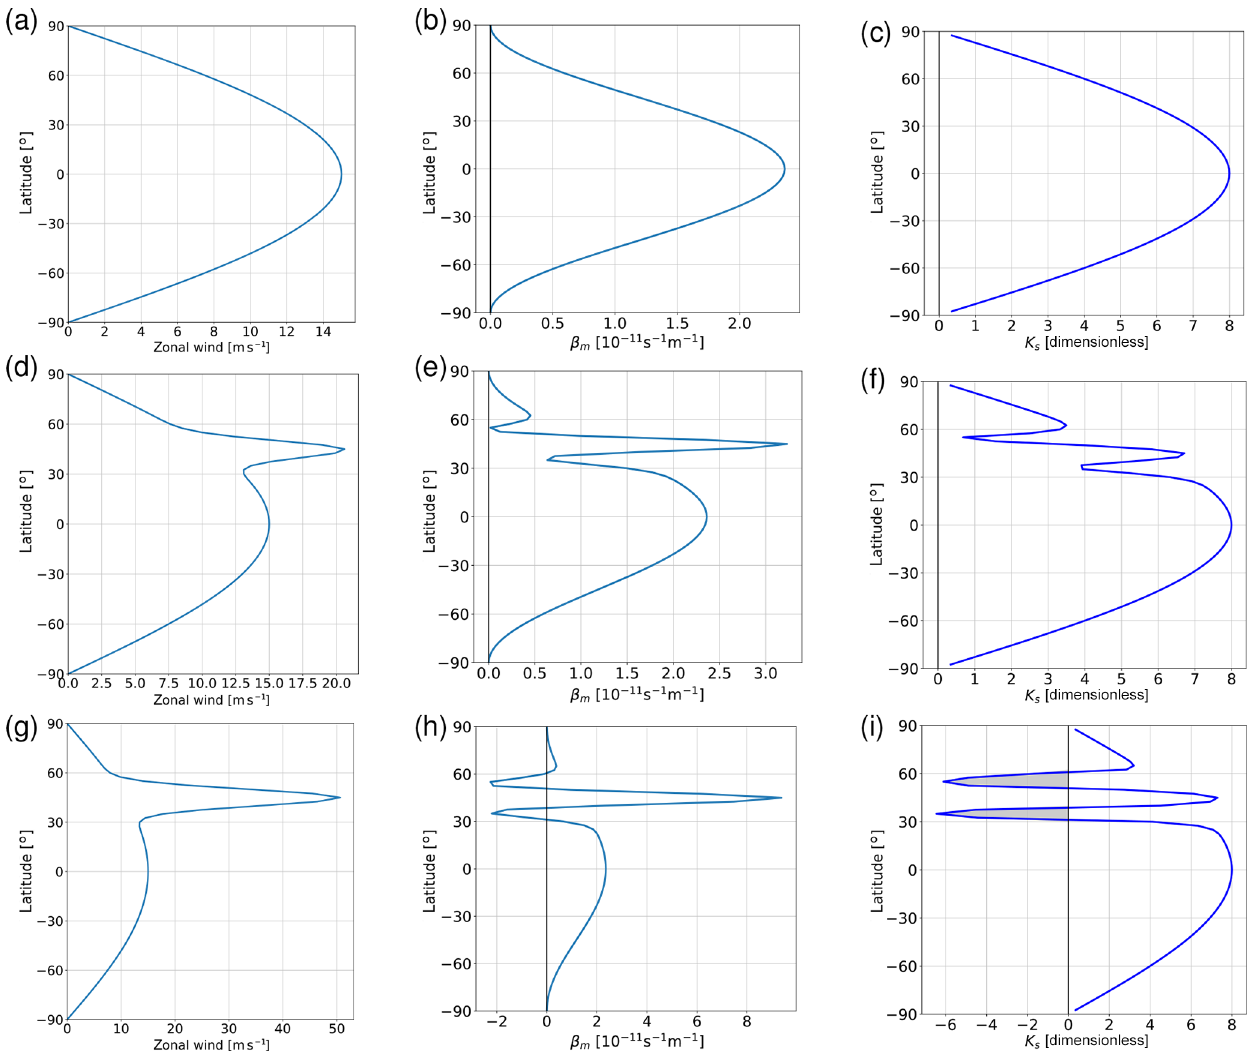
Figure 4. Diagnosing the zonally symmetric background state for three different cases: solid-body rotation (a–c) , a weak narrow jet with U J = 10ms − 1 (d–f) , and a strong narrow jet with U J = 40ms − 1 (g–i) . Panels (a, d, g) show the meridional wind profile u 0 (φ) , (b, e, h) show β M (φ) , and (c, f, i) show the dimensionless stationary wavenumber ˆ K s (φ) , where the negative values (shading) represent minus the imaginary part of ˆ K s